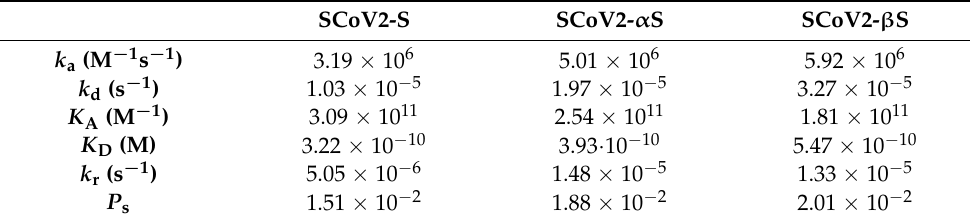
Table 1. Thermodynamic parameters of specific antibody interaction with variants of